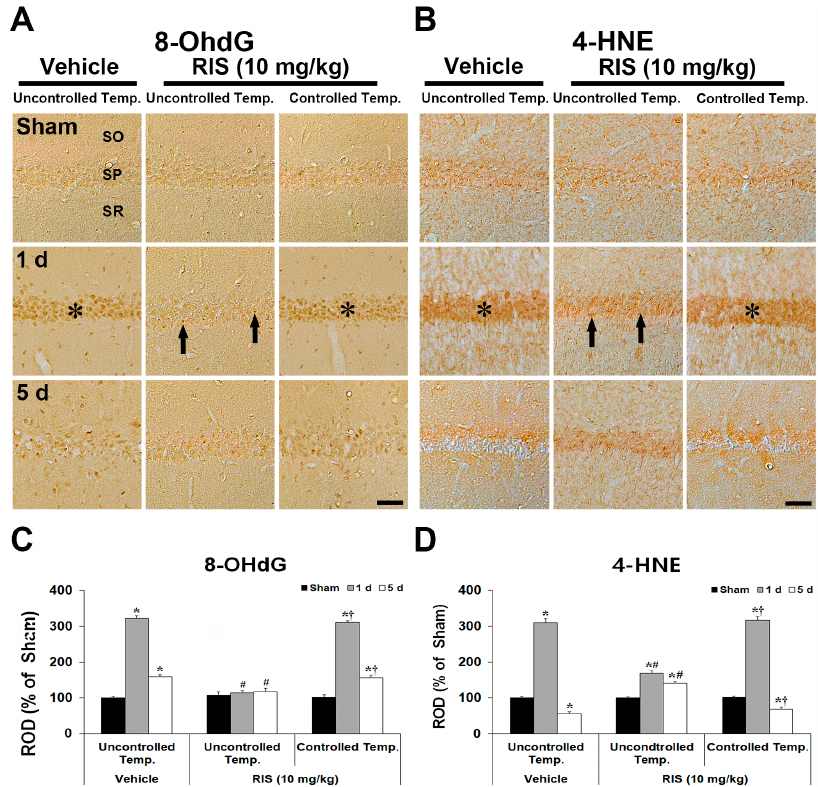
Figure 5. Effects of RIS on 8-OhdG and 4-HNE immunoreactivities after TI under UBT and CBT conditions. Representative images of immunohistochemistry for 8-OhdG ( A ) and 4-HNE ( B ) in the hippocampal CA1 after TI under UBT and CBT conditions. Under UBT condition, 8-OhdG and 4-HNE immunoreactivities in the TI + vehicle group are significantly increased in CA1 pyramidal neurons of the stratum pyramidale (SP, asterisks) in the TI + vehicle group under UBT and TI + RIS group under CBT at 1 day after TI; however, the immunoreactivities are significantly low (arrows) in the TI + RIS group under UBT. Scale bar = 50 μ m. Note analyses of 8-OhdG ( C ) and 4-HNE ( D ) immunoreactivity in the SP. A ratio of the ROD is calibrated as %, with the sham + vehicle group designated as 100%. The bars indicate the means ± SEM, n = 7/group, two-way analysis of variance (ANOVA) with a post-hoc Bonferroni’s multiple comparison test (* p < 0.05 vs. sham + vehicle